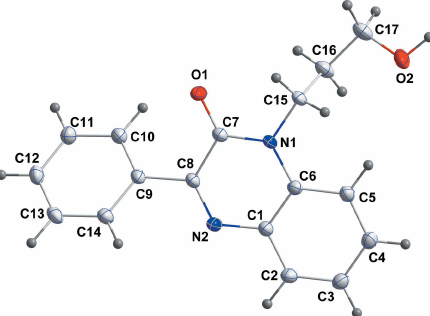
Figure 1 The molecular structure of the title molecule with the labelling scheme and 50% probability ellipsoids.